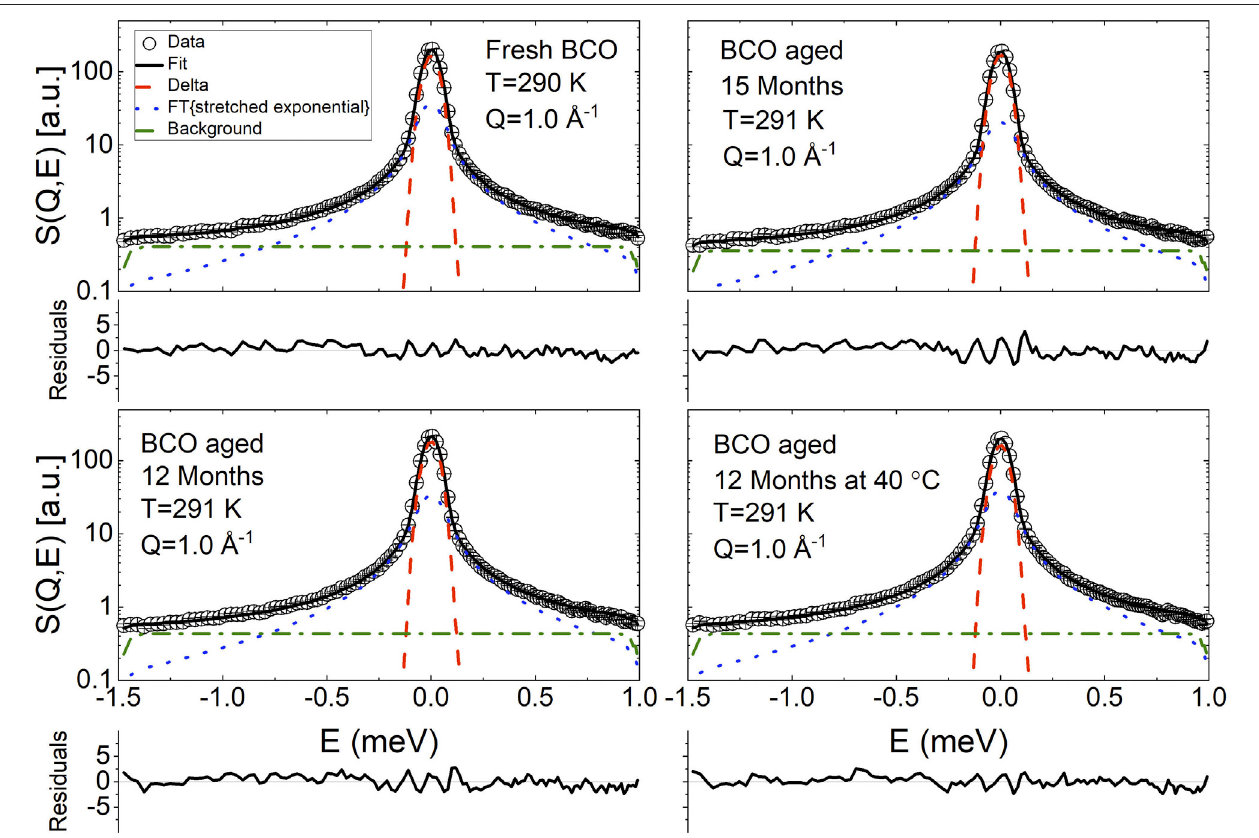
)areplottedtoprovideanindicationof error bar